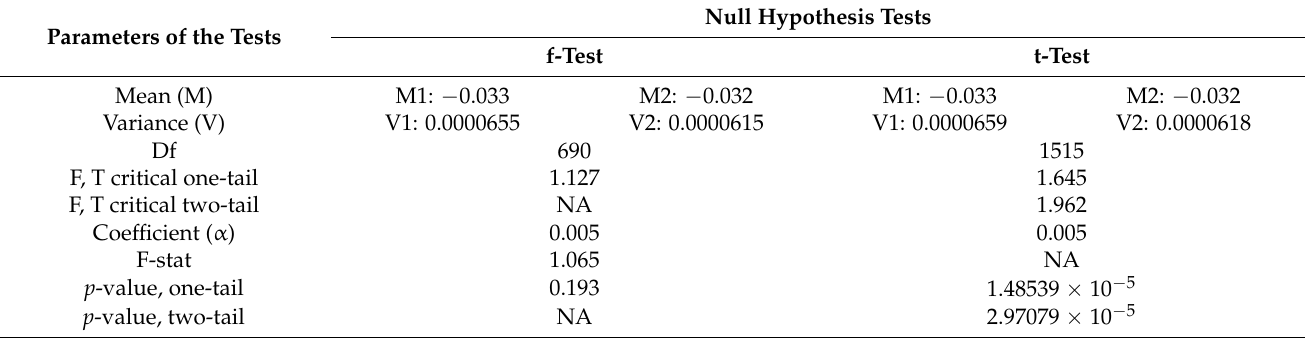
Figure 2. ( a ) Modeled structure of monomeric pMMO subunits ( α , β , and γ ) in M. trichosporium OB3b. Chain A is shown in light sea green color, Chain B is shown in purple color, and Chain C is shown in forest green color. ( b ) DOPE profiles of pMMO trimers. ( c ) DOPE profile of the monomeric pMMO. Table 3. Summary results of the null hypothesis tests.